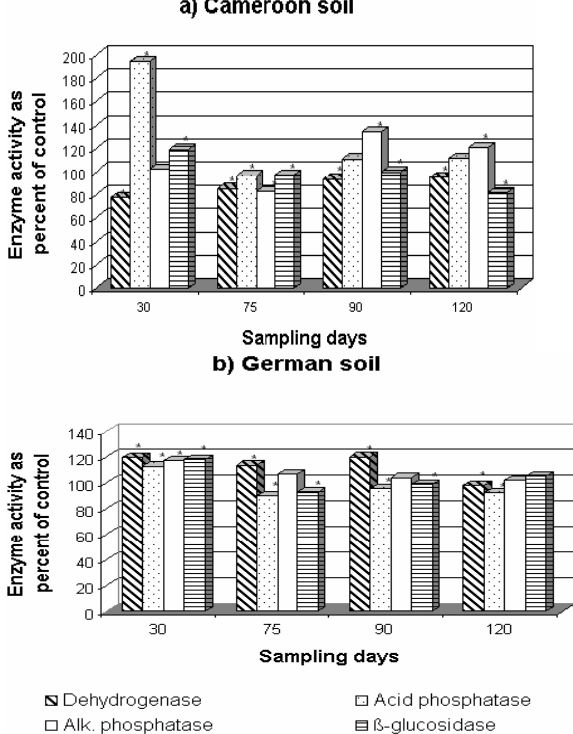
Figure 9: Effect of P-metalaxyl on enzyme activities in the Cameroonian (a) and German (b) soils. * P <0.05 between fungicide addition and no fungicide addition (paired Student